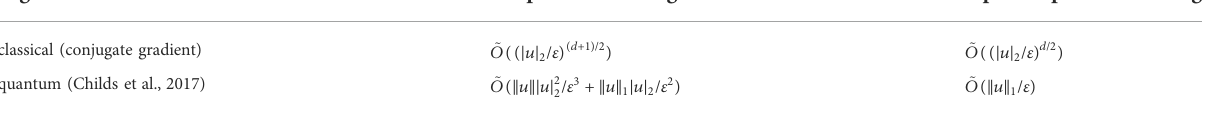
TABLE 1 Complexity results in Montanaro and Pallister (2016). The problem is a second order elliptical PDE, discretized with the fi nite element method, using piece-wise linear shape functions. Algorithm No preconditioning Optimal